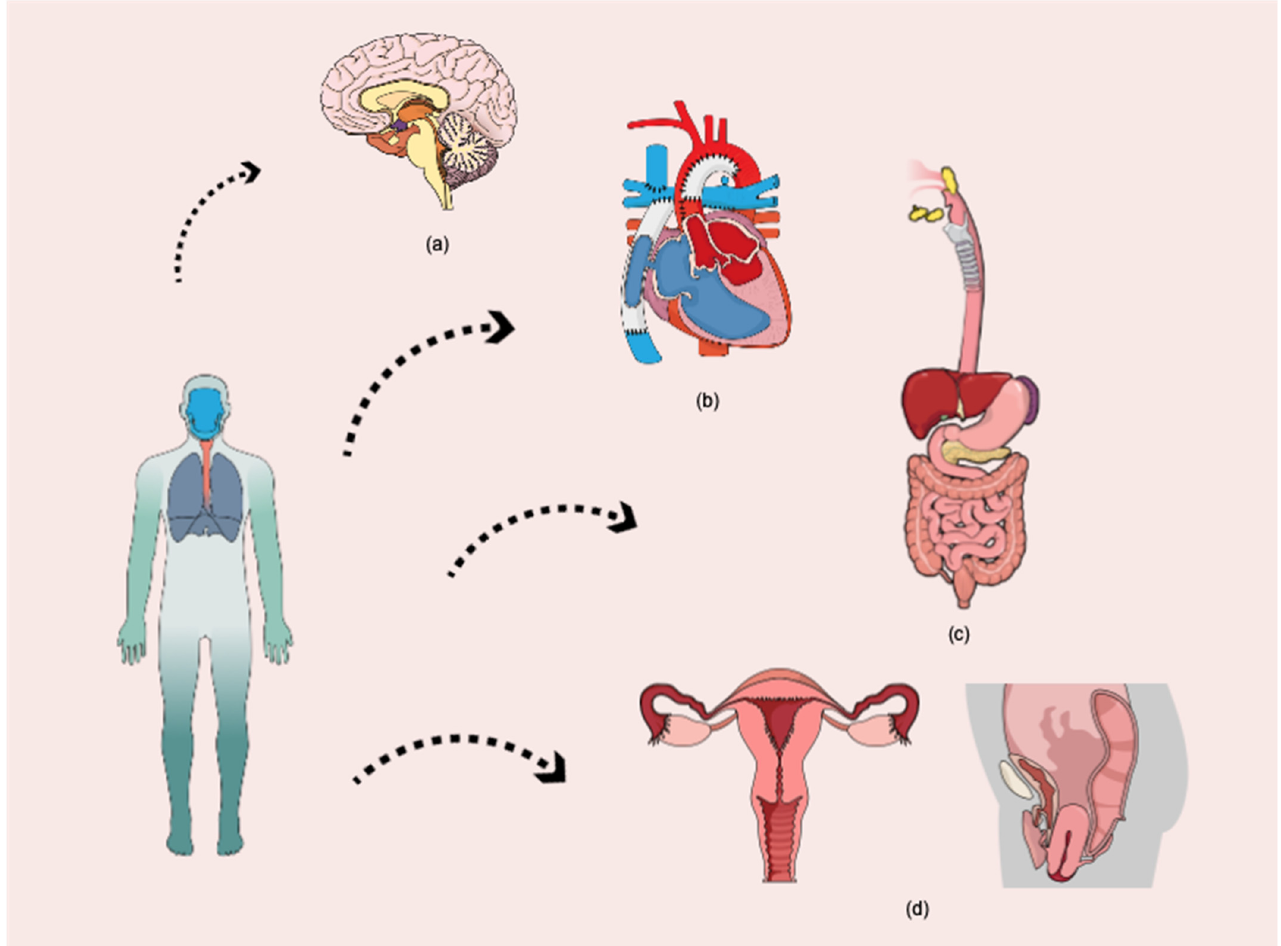
Figure 3. Major sites of micro- and nanoplastic particle accumulation in the human organism: ( a ) nervous system, ( b ) cardiovascular system, ( c ) gastrointestinal system, ( d ) reproductive system.